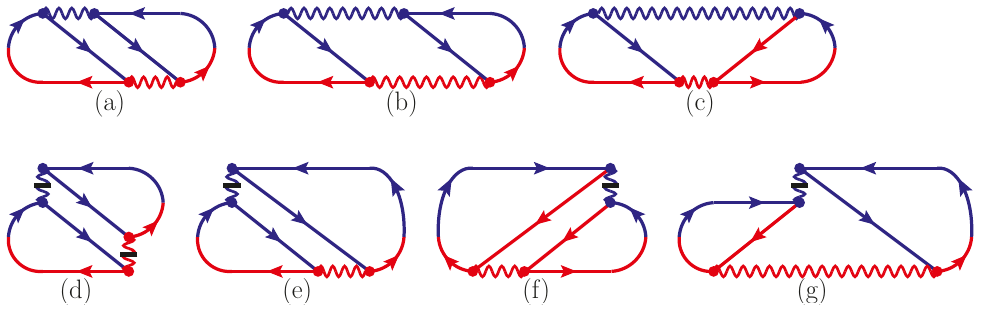
Figure 14 . Time-ordered interference diagrams for e ! e (cid:22) ee in large- N f QED [16]. Complex conjugates should also be included by taking 2 Re[ (cid:1) (cid:1) (cid:1) ] of the above.